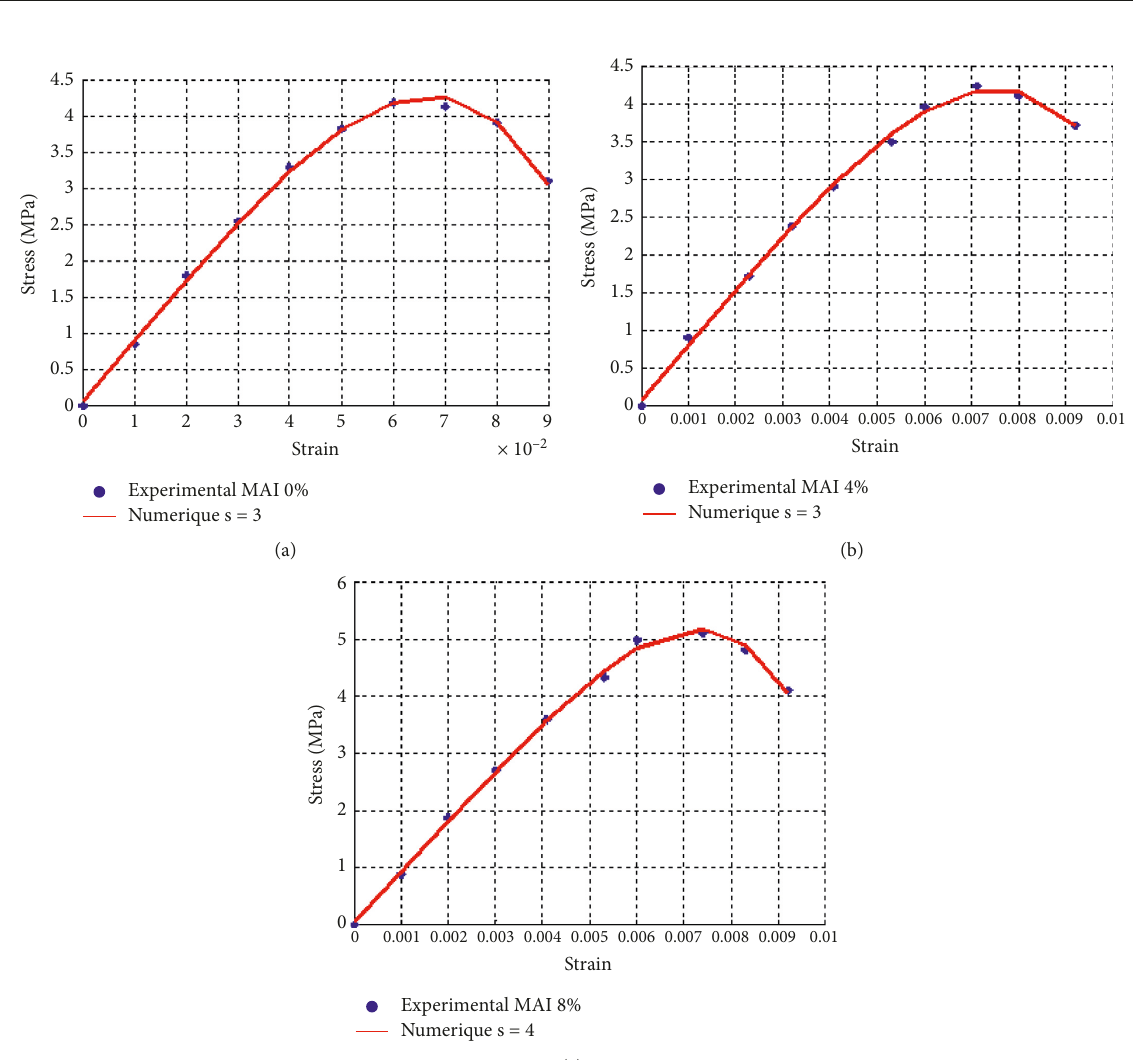
Figure 7: Simple compression stress based on the strain of MAI (0%, 4%, and